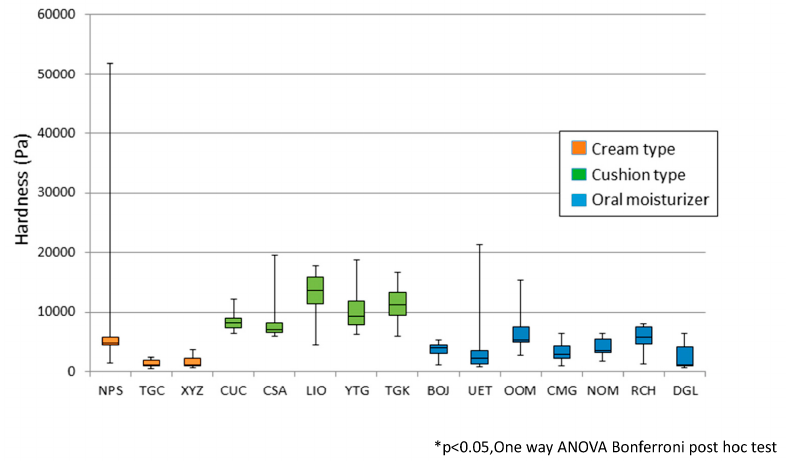
Figure 3. Hardness of seven kinds of denture adhesives and eight kinds of oral moisturizers.